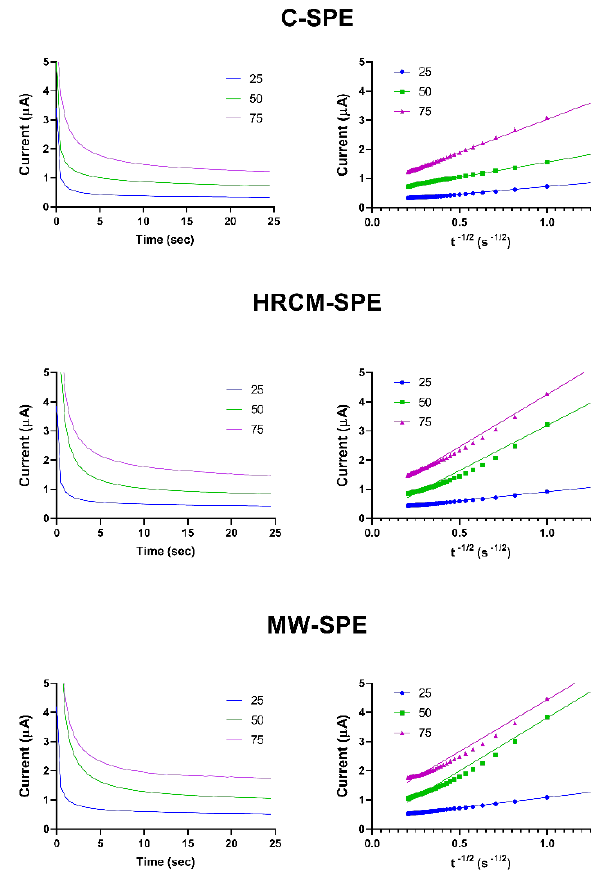
Figure 5. Chronoamperograms of C-SPEs, HRCM-SPEs functionalized with 5 mg/mL, and MW-SPEs functionalized with 10 mg/mL in PBS at different concentrations of ascorbic acid (25, 50, and 75 µM (graphs on the left)). Cottrell plots of I vs. t −1 /2 (s −1 /2 ) of the chronoamperometric data obtained for 25, 50, and 75 µM of AA (graphs on the right).